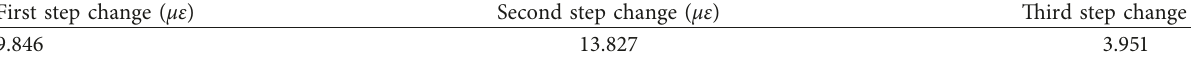
Table 3: Strain amplitude formed by the flame front passing through the FBG sensor in the third